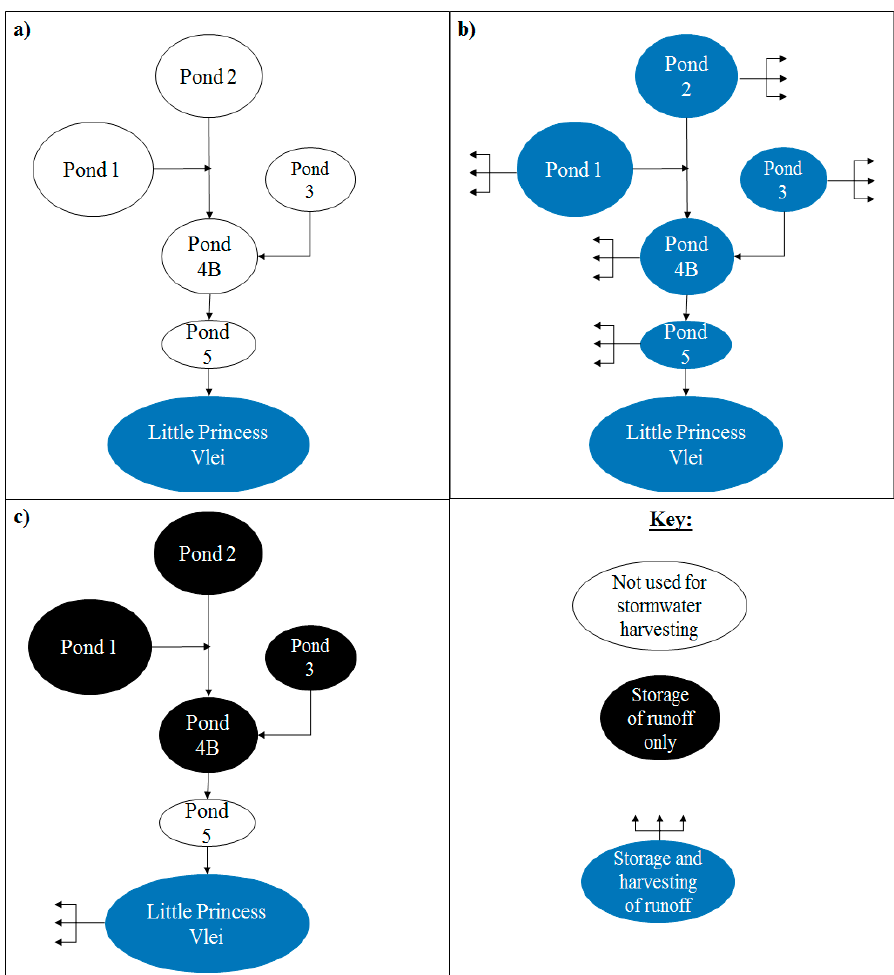
Figure 4. Schematic of RTC options: ( a ) RTC Strategy A; ( b ) RTC Strategy B; ( c ) RTC Strategy C.